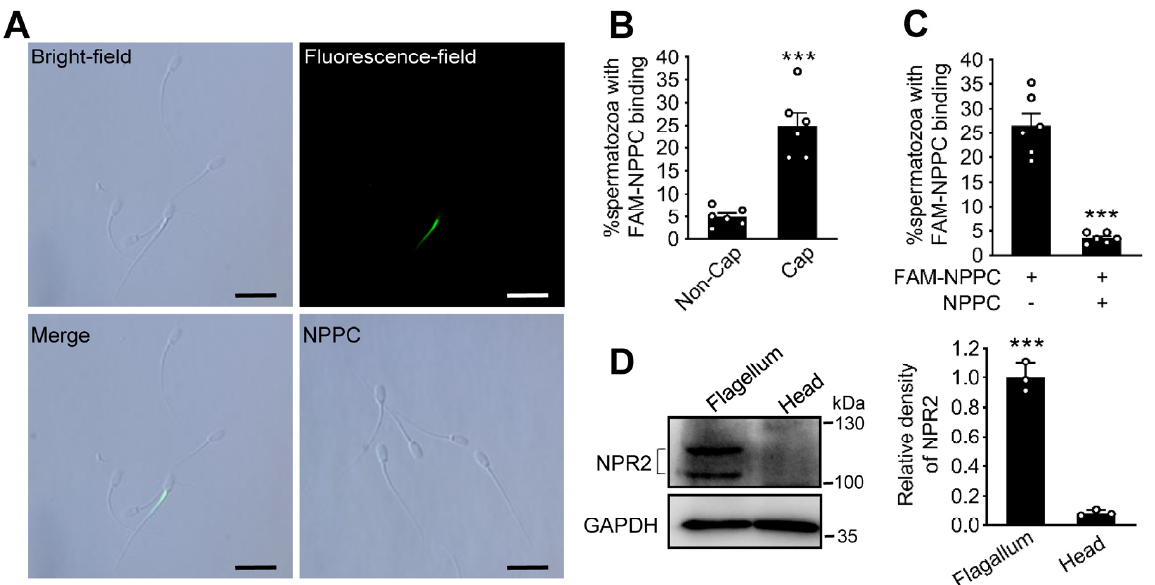
Figure 2. Expression of NPR2 on porcine sperm. ( A ) The capacitated spermatozoa were incubated with 100 nM FAM-NPPC for 30 min to ensure full reaction. The binding of FAM-NPPC to the spermatozoa was visualized by fluorescence and merge fields. Scale bars, 20 µ m. Representative examples of three independent experiments are shown. ( B ) The percentage of spermatozoa with FAM- NPPC binding before and after capacitation ( n = 6 independent experiments). ( C ) Comparison of FAM-NPPC binding in capacitated spermatozoa without or with 1 μ M NPPC incubation ( n = 6 independent experiments). ( D ) The protein levels of NPR2 in the capacitated sperm head and flagellum ( n = 3 independent experiments). Two immunoreactive bands of NPR2 antibody were observed in the fraction of sperm flagellum. GAPDH was used as an internal control. Bars indicate mean ± SEM. Statistical analysis was performed by two-tailed unpaired Student’s t -test. *** p < 0.001. Each data point represents a biologically independent experiment. Non-Cap, non-capacitated spermatozoa; Cap, capacitated spermatozoa.